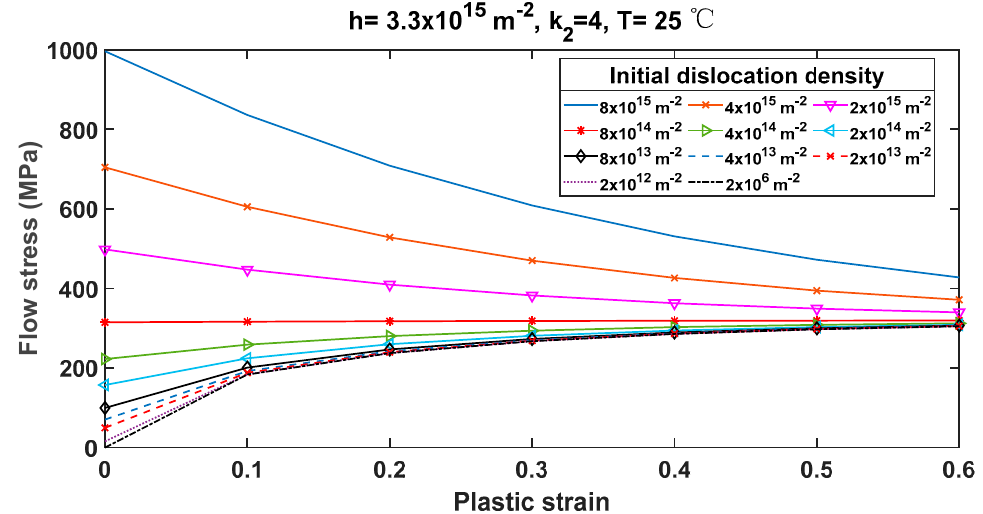
Figure 7. Effects of the initial dislocation density on the flow stress for fixed values of parameters h and k as well as temperature.